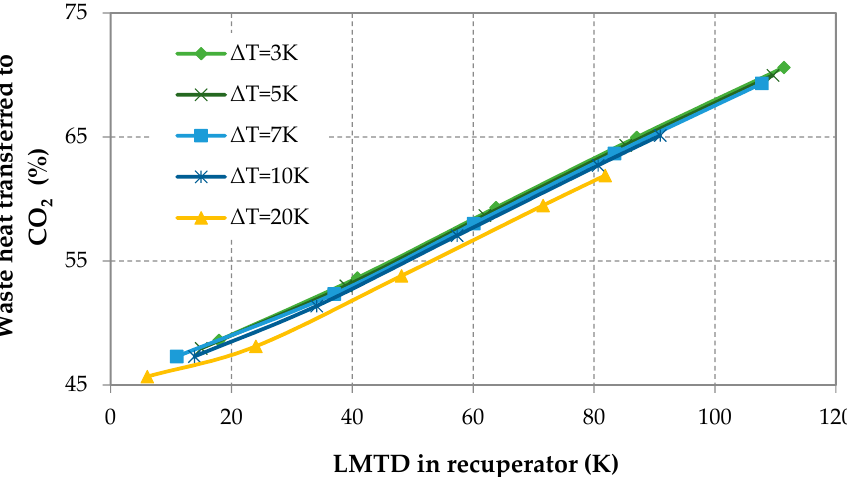
Figure 9. Relationship between the LMTD and percent of waste heat transferred to CO 2 for varied temperature differences between CO 2 and the exhaust gases at the inlet and outlet of the heat